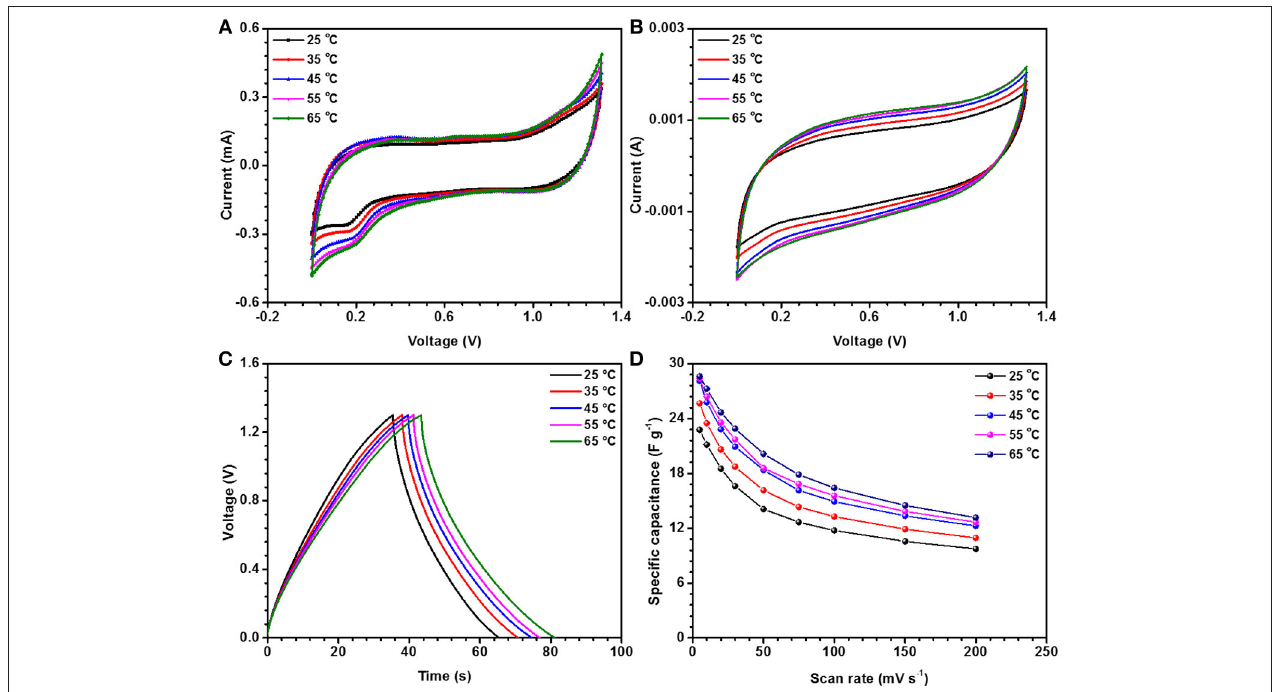
FIGURE 7 | CV measurements at different temperature for the device (A) at 5mV s − 1 and (B) at 50mV s − 1 , (C) CD measurements for NaFePO 4 //AC device at different temperature, and (D) variation of specific capacitance with scan rate.